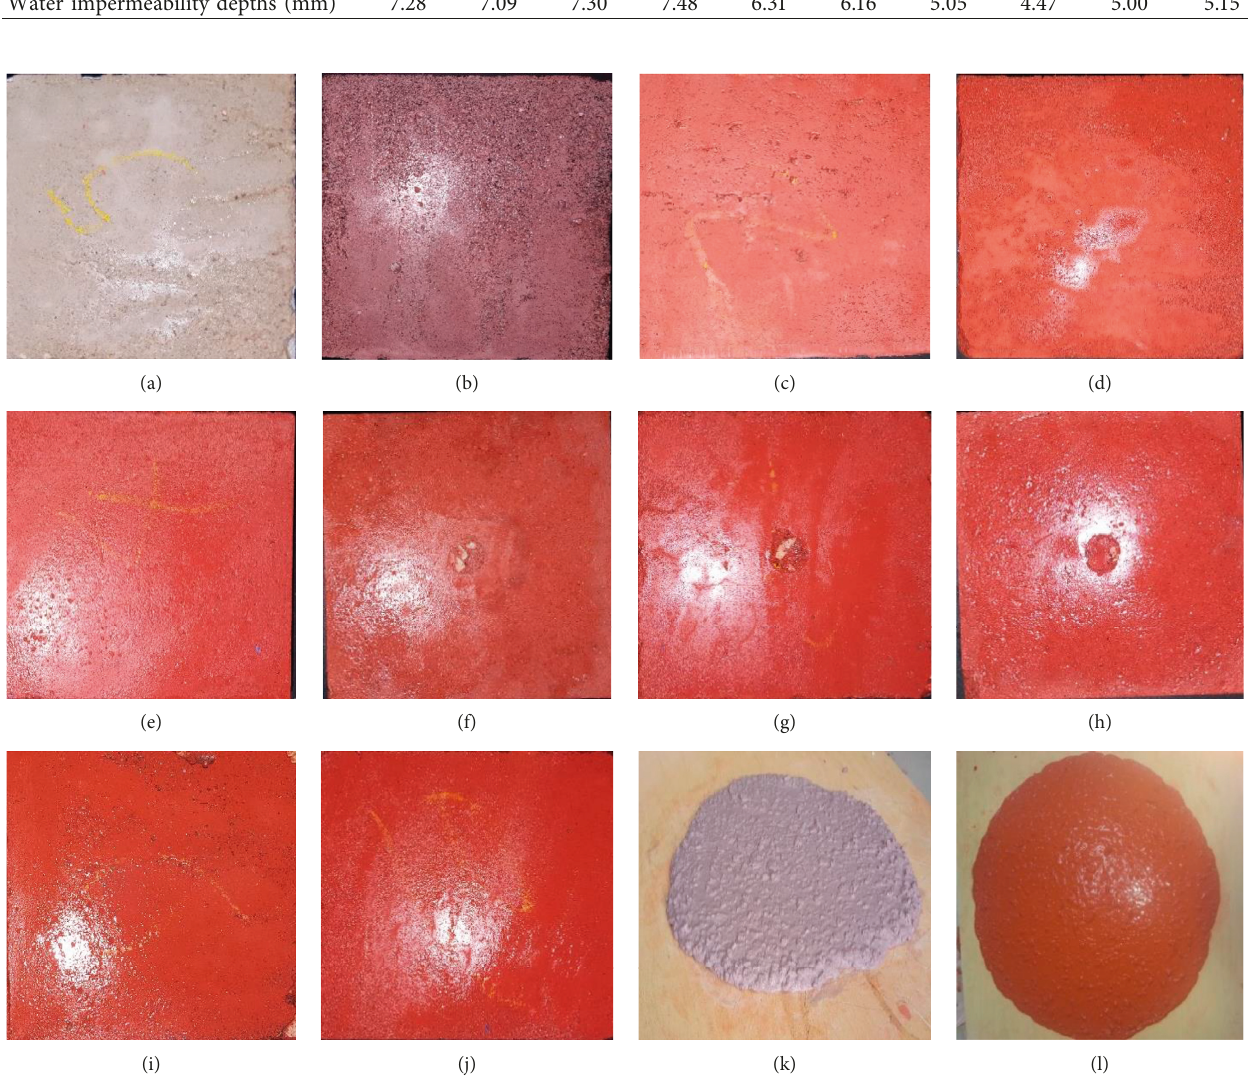
Figure 8: Colour parameters of hardened SCC series from M1 series to M10 series and slump flow spread diameter of some fresh SCC series (M2 series and M4 series). (a) M1 (LP-pigment free), (b) M2 (MMP-pigment free), (c) M3 (1% pigment), (d) M4 (2% pigment), (e) M5 (3% pigment), (f) M6 (4% pigment), (g) M7 (5% pigment), (h) M8 (6% pigment), (i) M9 (7% pigment), (j) M10 (8% pigment), (k) M2 (MMP-pigment free), and (l) M4 (2%